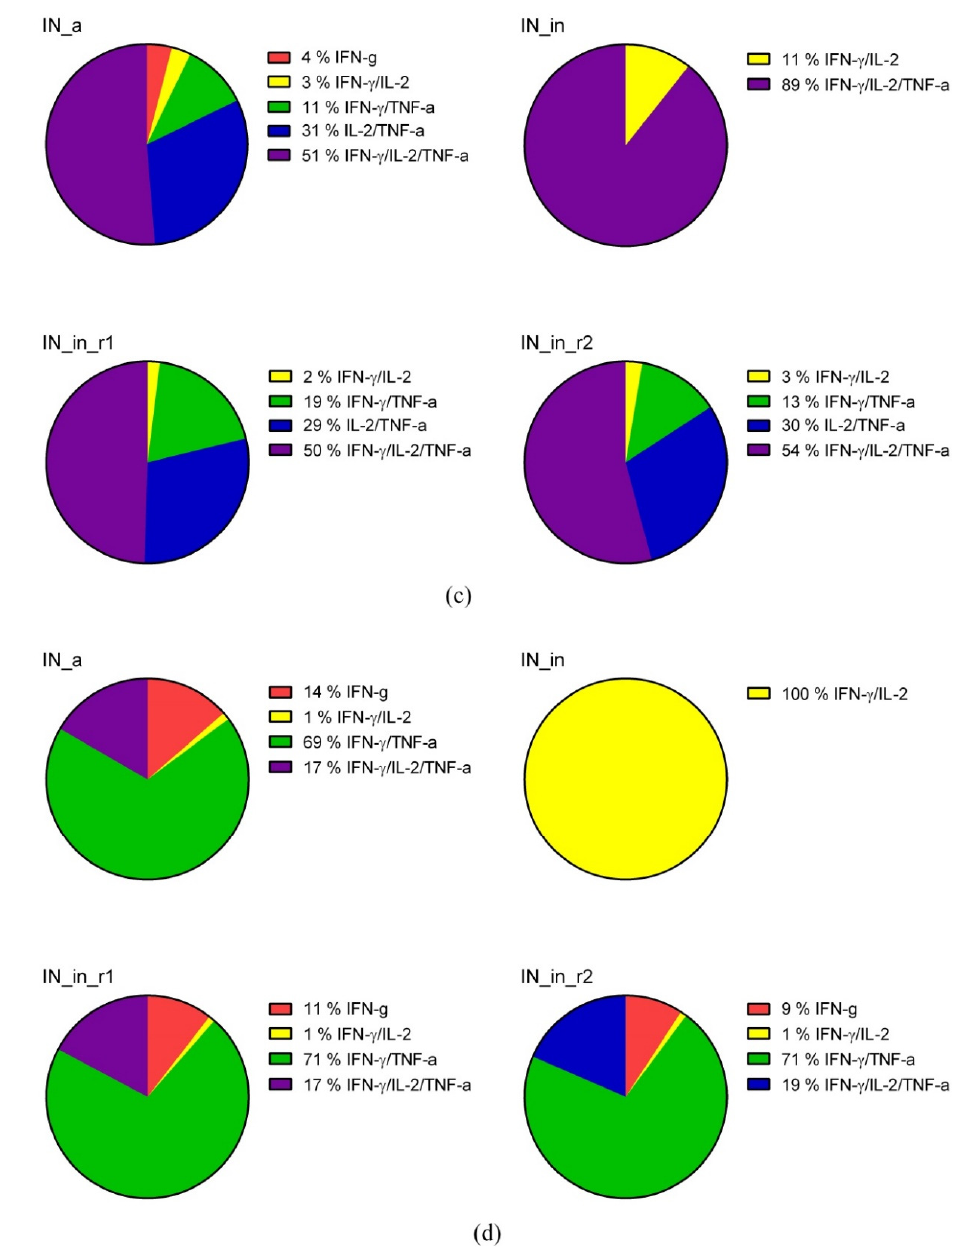
Figure 10. DNA immunization of mice with HIV-1 integrase variants induces multicytokine response of CD4+ and CD8+ T cells. CD4+ ( a , c ) and CD8+ ( b , d ) T cell response of mice DNA immunized by IN_a, IN_in, IN_in_r1, and IN_in_r2 (Table 1, Series I) to in vitro stimulation with MIN pool of IN-derived peptides (Supplementary Table S1) detected by flow cytometry with ICCS assessment presented as percent of total CD4+ ( a ), total CD8+ T cells ( b ), and pie diagrams illustrating distribution of populations of CD4+ ( c ) and CD8+ ( d ) T cells responding to stimulation by producing different cytokines, in %. Percent of the total responsive CD4+ or CD8+ T-cells was determined for every population of responding cells after subtraction of % of cells stimulated by medium alone; data represent two independent experiment runs, each done in duplicate. ( a , b ) Whisker bars represent median, quartiles, and minimum and maximum values of % of cells registered in each group; median values used to build whisker bars are presented in the table beneath the panels. ( c , d ) To build pie diagrams, all MIN-specific T cell responses by individual mice in each group were summed, taken for 100% and response of each type was represented as % of the total. *— p < 0,05 in ( a , b ), comparison of IN DNA- and vector-immunized mice, Kruskal–Wallis and Mann–Whitney tests; respective values in the data table are also indicated with * and given in red. Mouse groups were similar with respect to the levels of unspecific reactivity and cell viability demonstrating equal % of cytokine-producing T cells mock-stimulated with medium, or stimulated with mitogen